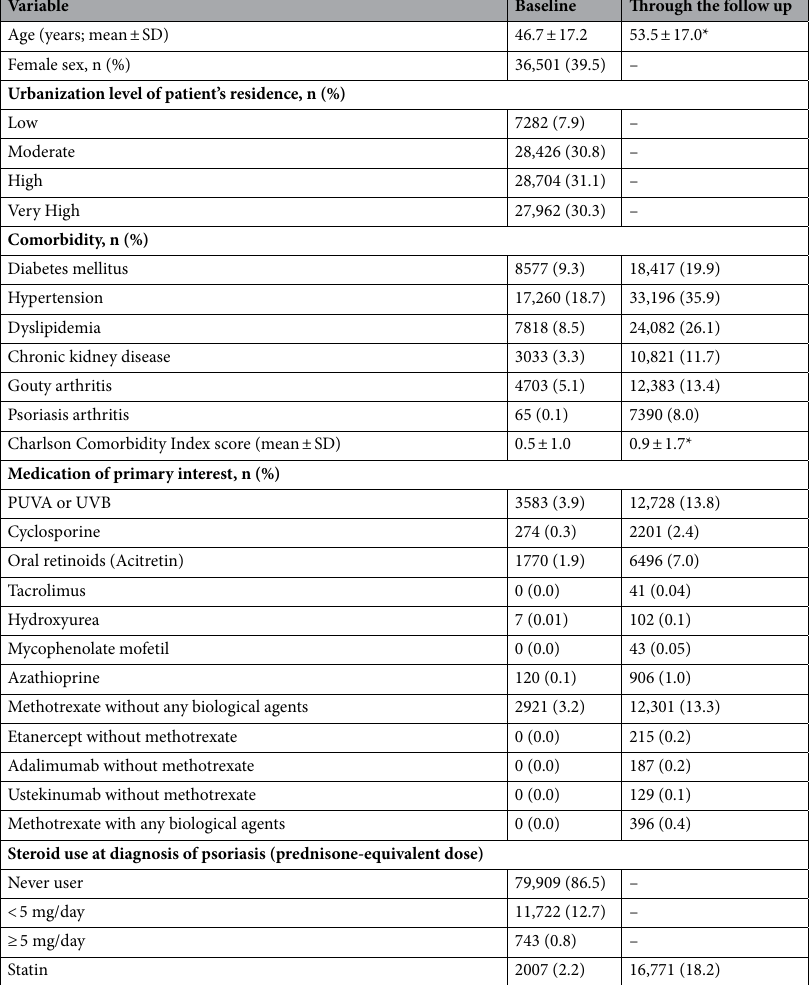
Table 1. Demographic and clinical characteristics of patients at baseline and through follow-up. SD standard deviation, PUVA photochemotherapy, UVB ultraviolet B. Data are presented as frequency (percentage) or mean ± standard deviation. *At the end of the